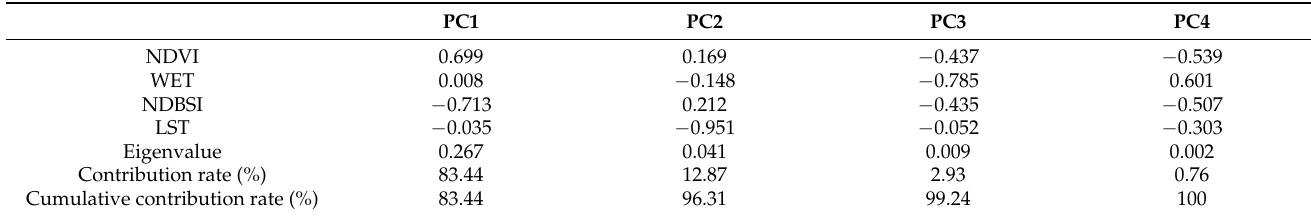
Table 4. Principal component analysis results of remote sensing ecological index in 2010.